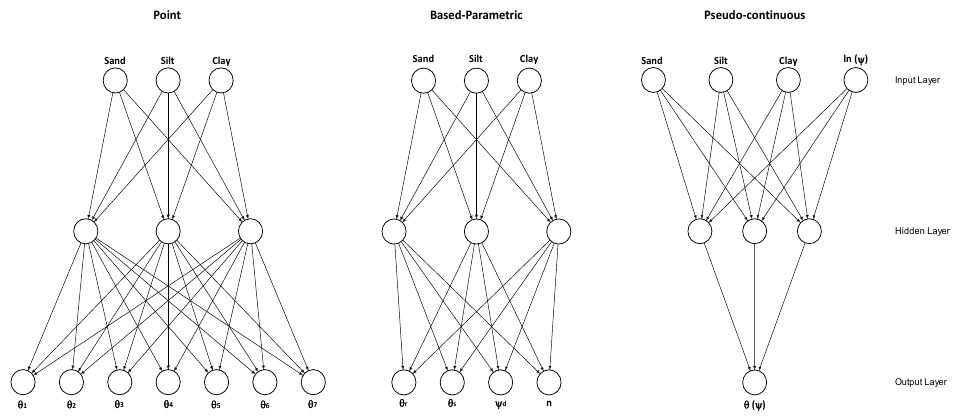
Figure 2. Schematic representation of principal types ANNs. Recovered from